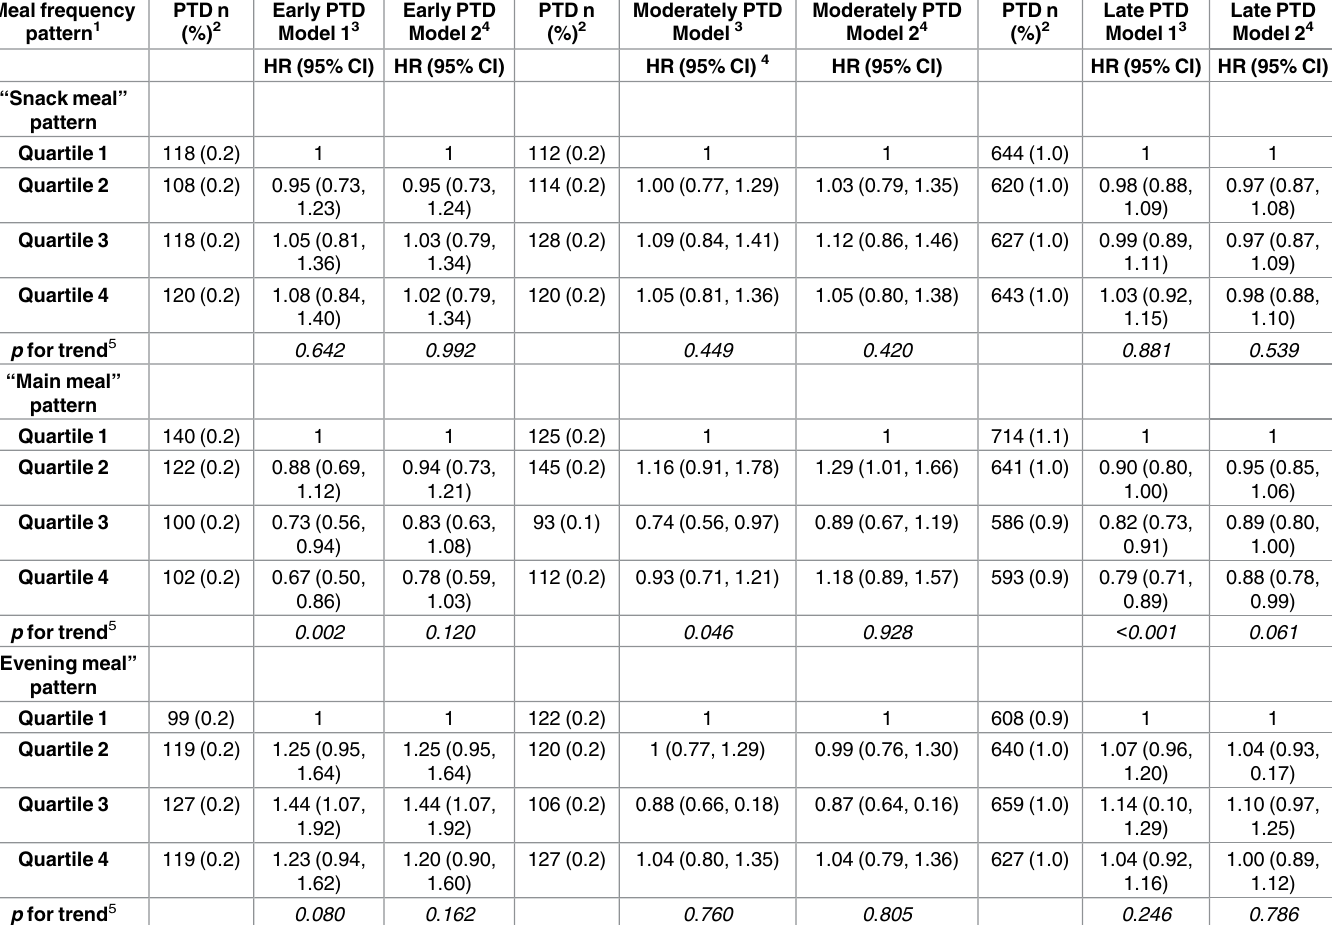
Table 3. Associations between meal frequency patterns and preterm delivery in 65,487pregnant women in the Norwegian Mother and Child Cohort Study (MoBa) Meal frequency pattern